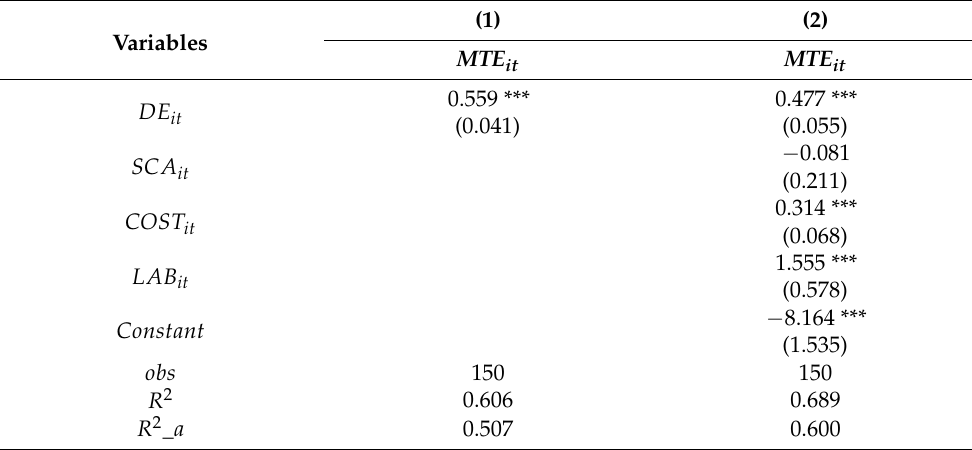
Table 7. Benchmark regression.